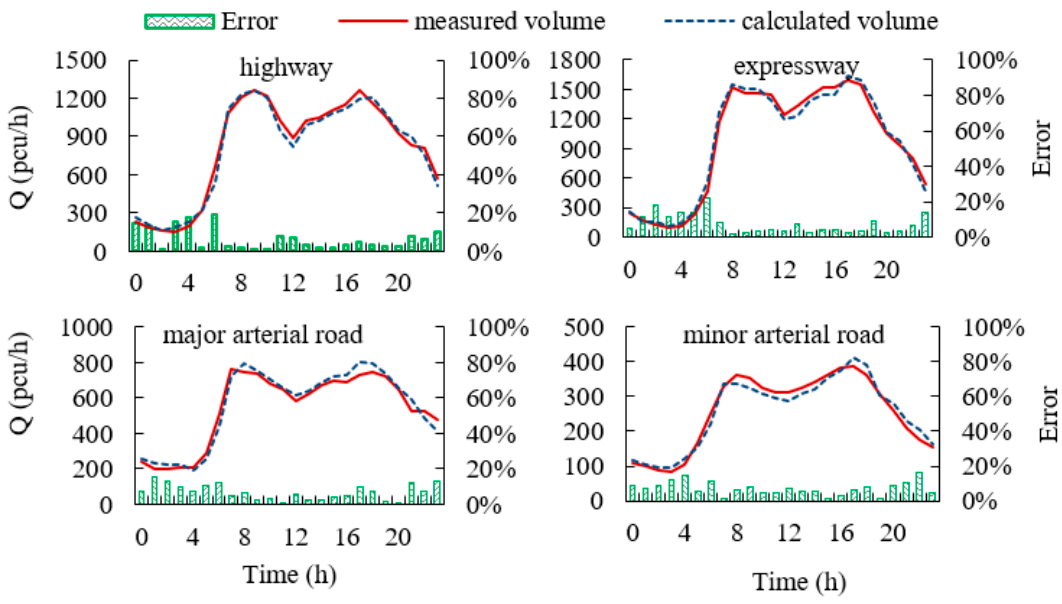
Figure 13. Measured volume and calculated volume curves on different road types. The average relative error of the Beijing-Kaisha highway is 7.19%, and the average absolute error of that road is 48 pcu/h. The average relative error of the North Fourth Ring Expressway is 7.47%, and the average absolute error of that road is 49 pcu/h. The average relative error of the Fangzhuang major arterial road is 6.83%, and the average absolute error of that road is 32 pcu/h. The average relative error of the Guang’an minor arterial road is 7.25%, and the average absolute error of that road is 16 pcu/h. The accu- this paper is relatively high.